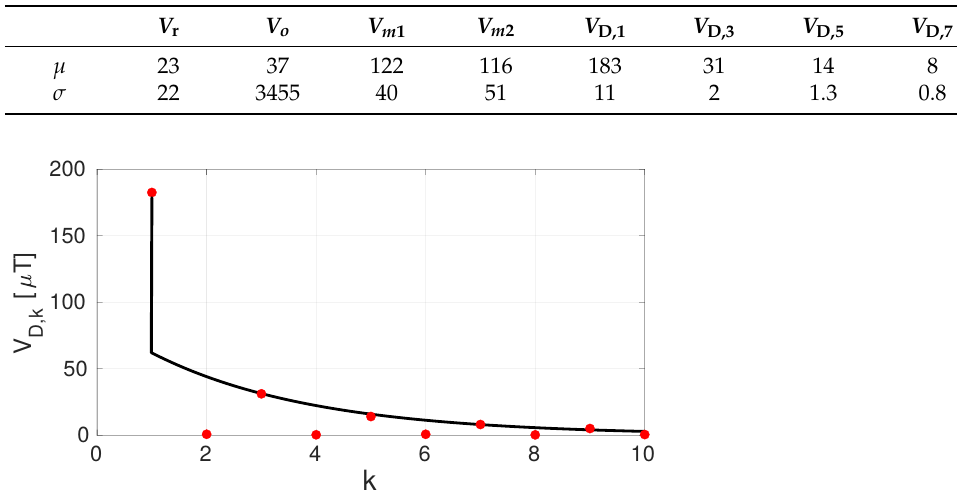
Figure 16. Mean µ of the measured V D,k offset terms as a function of k (red dots). An exponential fit to V D,k , for k > 1 and odd, is added.